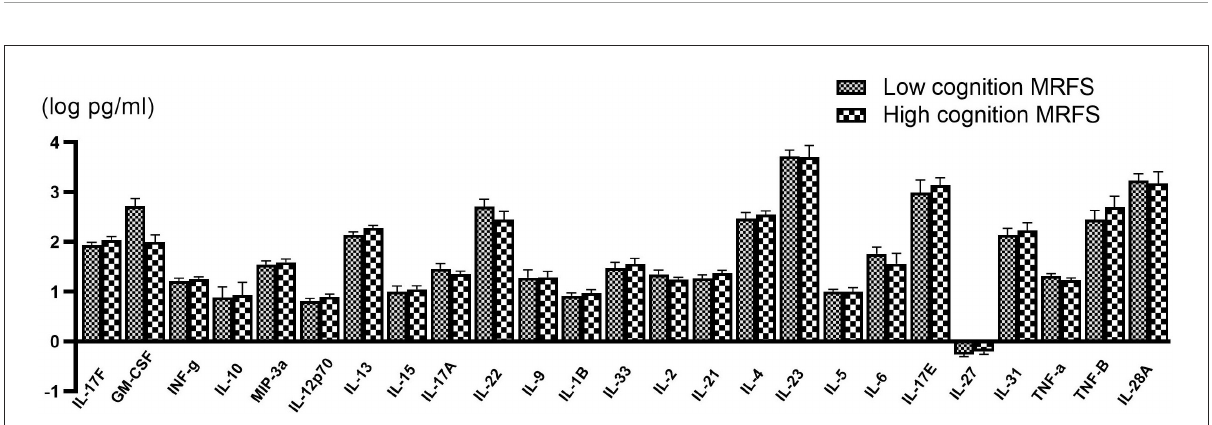
FIGURE2 Comparison of various serum cytokine levels between poor ( n = 58) and good ( n = 56) cognitive recovery group. Data are presented as mean ± SD.